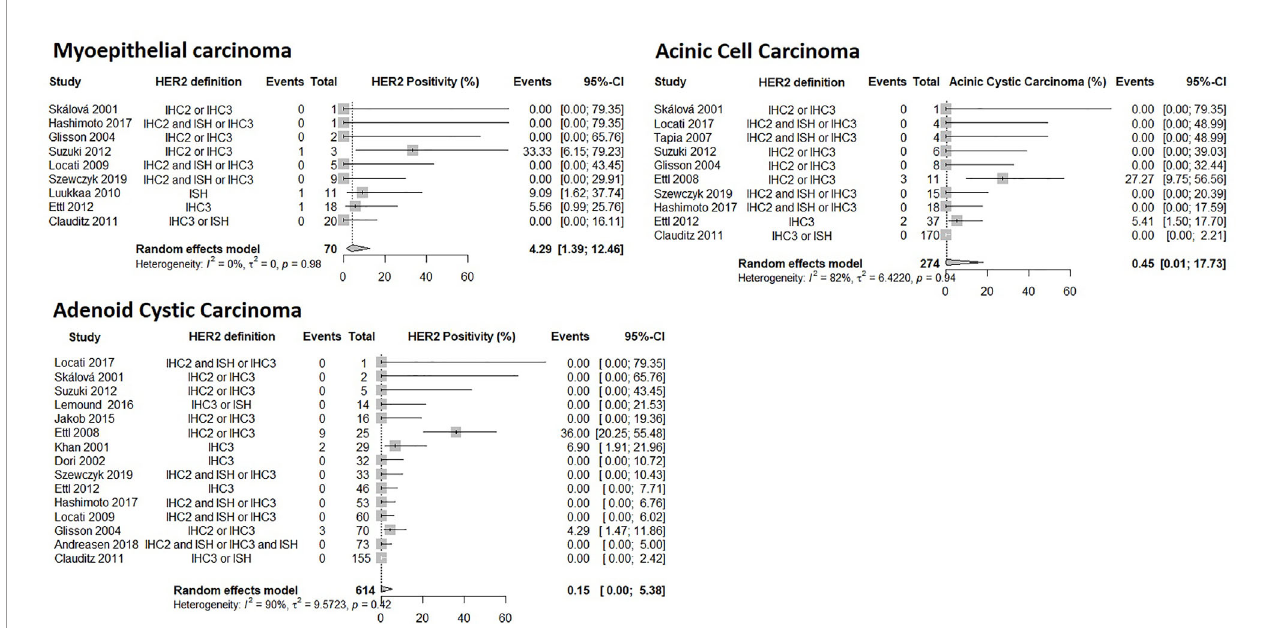
FIGURE 6 | Forrest plot of HER2 Prevalence among SGC subtypes: Myoepithelial carcinoma, Acinic Cell Carcinoma, Adenoid Cystic Carcinoma.